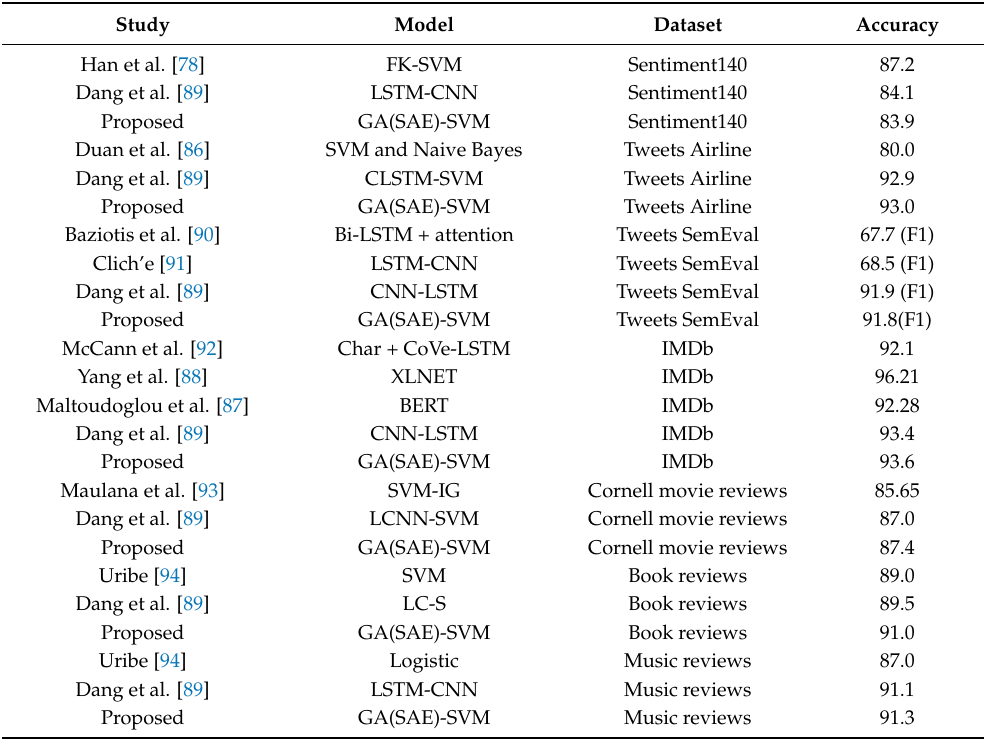
A comparison of the proposed model and state-of-the-art approaches based on specified